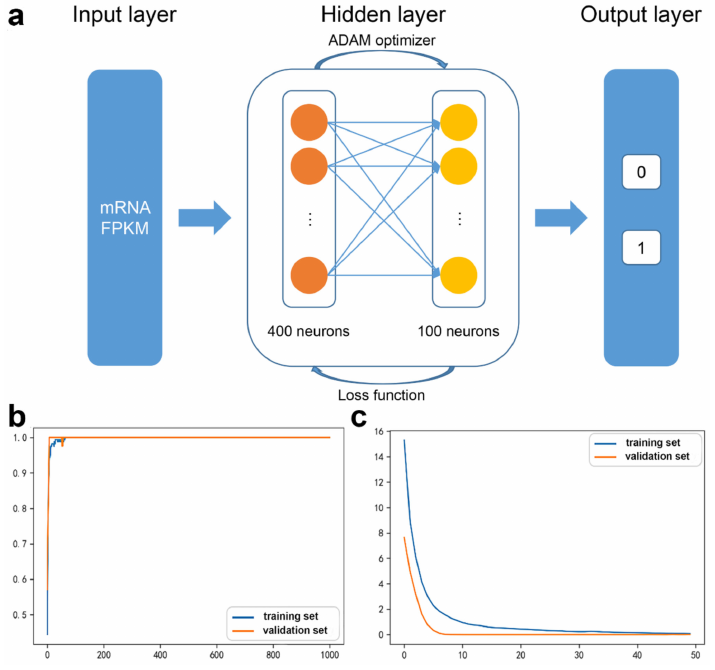
Figure 2. The mRNA DNN model: ( a ) The DNN model structure, ( b ) accuracy curve, and ( c ) loss curve.